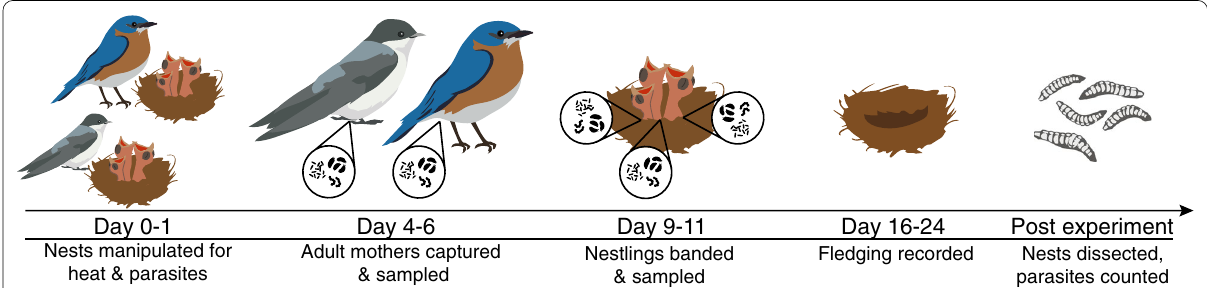
Fig. 1 Eastern bluebird and tree swallow nests were manipulated to test the effects of heat treatment and parasitism on microbiota. Days represent nestling age from hatch